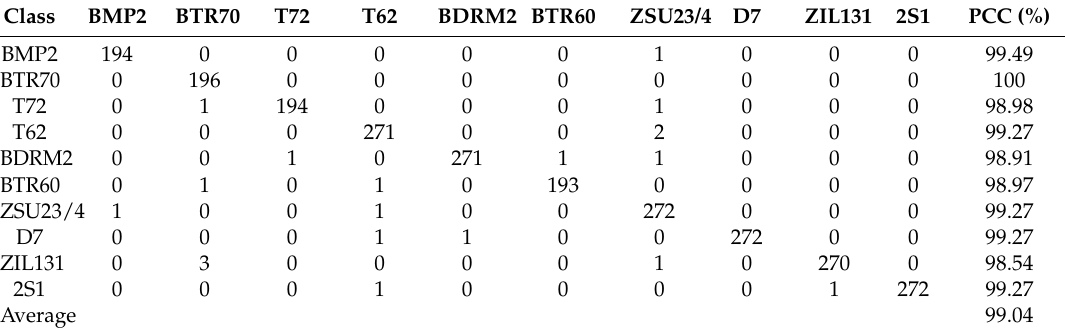
Table 3. Recognition results of the proposed method under standard operating condition